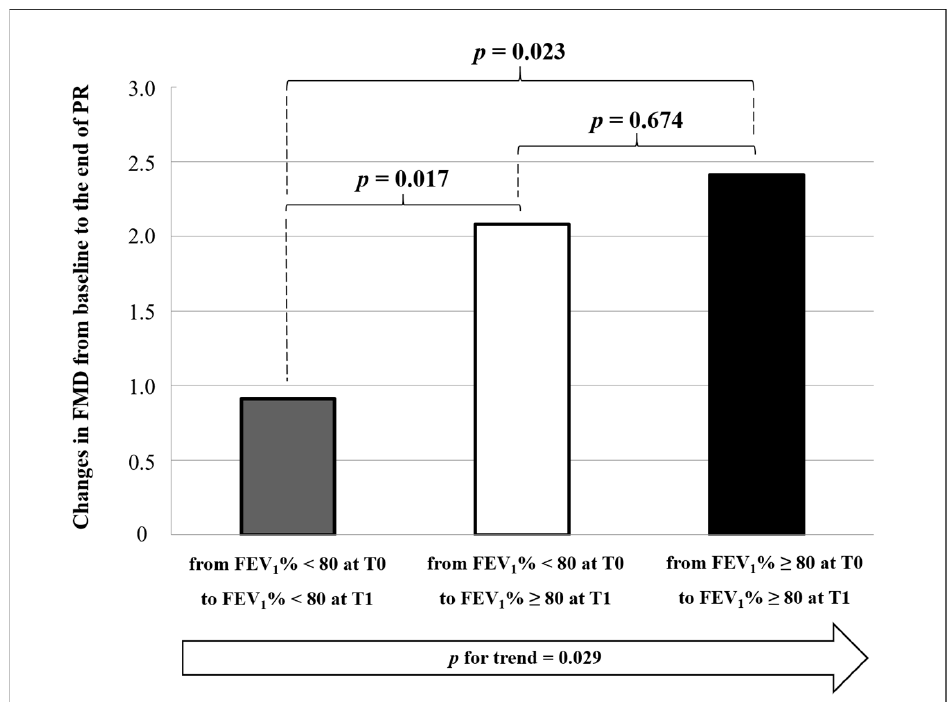
Figure 3. Changes in flow-mediated dilation (FMD) from baseline (T0) to the end of pulmonary rehabilitation (T1) according to forced expiratory volume in 1 s (FEV 1 ). All p -values are for non- parametric comparisons.